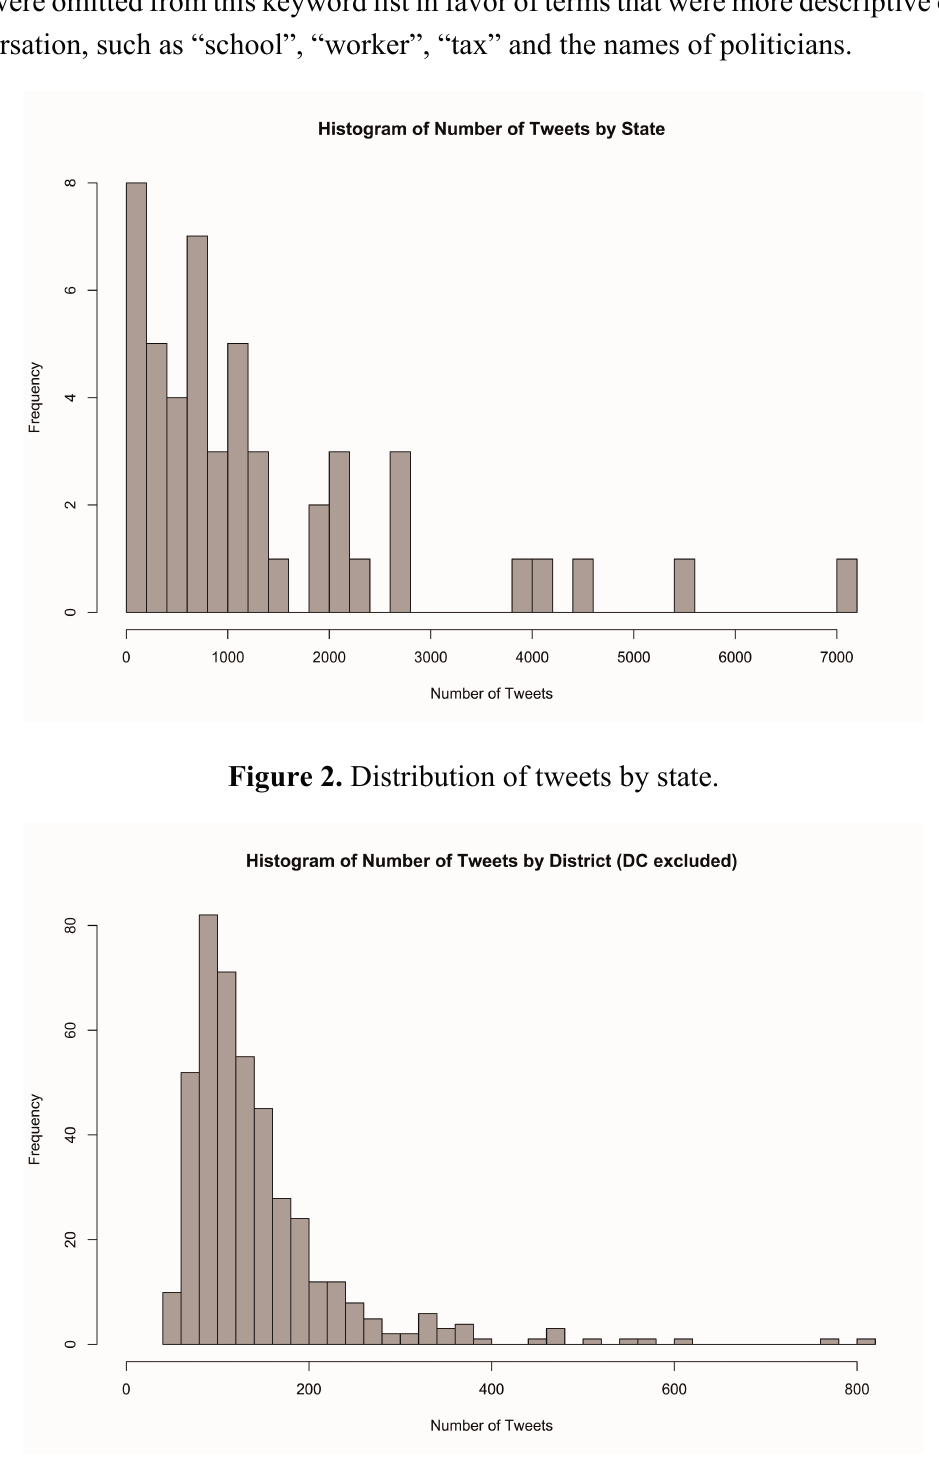
Figure 3. Distribution of tweets by congressional